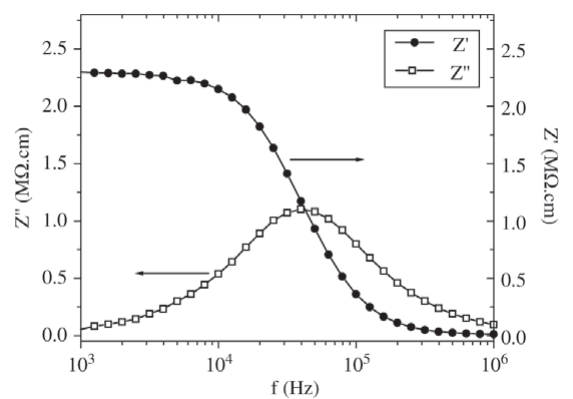
Figure 3. Plots of the imaginary and real parts of Z* as functions of the frequency. The maximum value of Z’’ and the inflexion point in the Z’ curve are observed at the relaxation frequency f